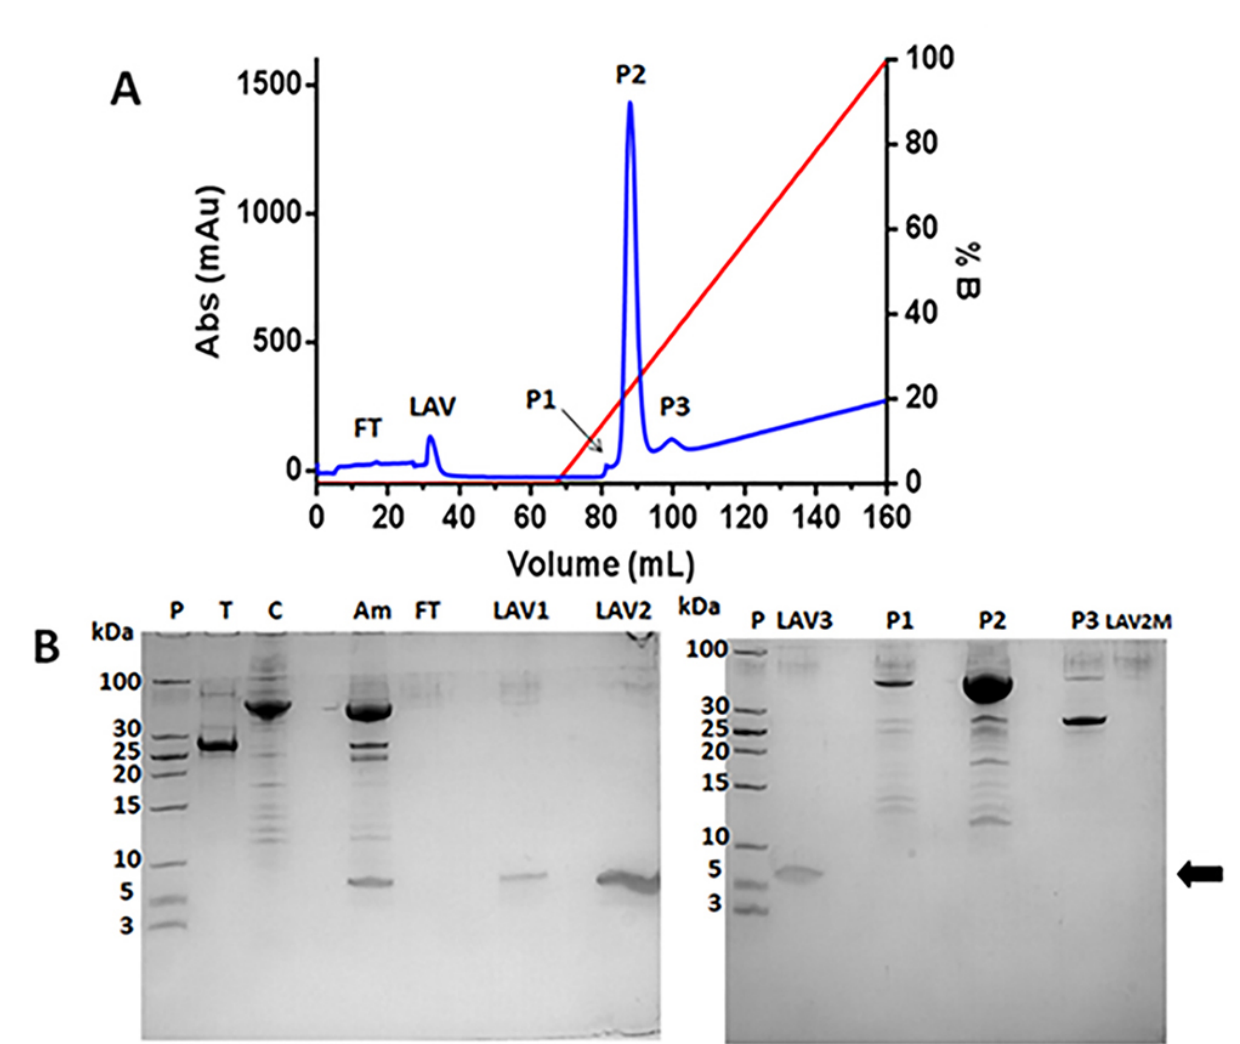
Figure 5. Second purification step to purify AgCecropB. ( A ) Chromatogram purification by affinity Ni 2+ Histrap columns (GE healthcare). Blue line represents sample absorbance measure in 280 nm and red line represent elution buffer B (50 mM sodium phosphate, 0.5 M NaCl, 1 M imidazole [pH 7,0]) concentration during experiment. FT: flowthrough; LAV: peak obtained during washing column buffer (50 mM sodium phosphate, 0.5 M NaCl [pH 7,0]). P1, P2, P3: peaks eluted during buffer B gradient. ( B ) 18% SDS-PAGE gel with chromatography fractions. P: molecular mass standard; T: TEV endoprotease (28 kDa); C: P2 containing Hisx6MBP-AgCecropB; Am: proteolysis sample after 96 hours assay. FT: flowthrough; LAV1, LAV2, LAV3: collected fractions from LAV peak; P1, P2, P3: eluted samples during buffer B gradient; LAV2M: Histrap column sample collected after final washing (2 M imidazole). Arrow indicates recombinant peptide AgCecropB identified in LAV